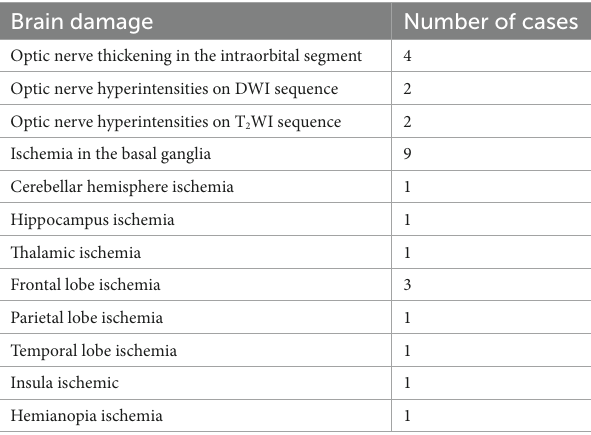
TABLE 5 Analysis of MRI findings in the brains of patients in the acute stage of the disease. Brain damage